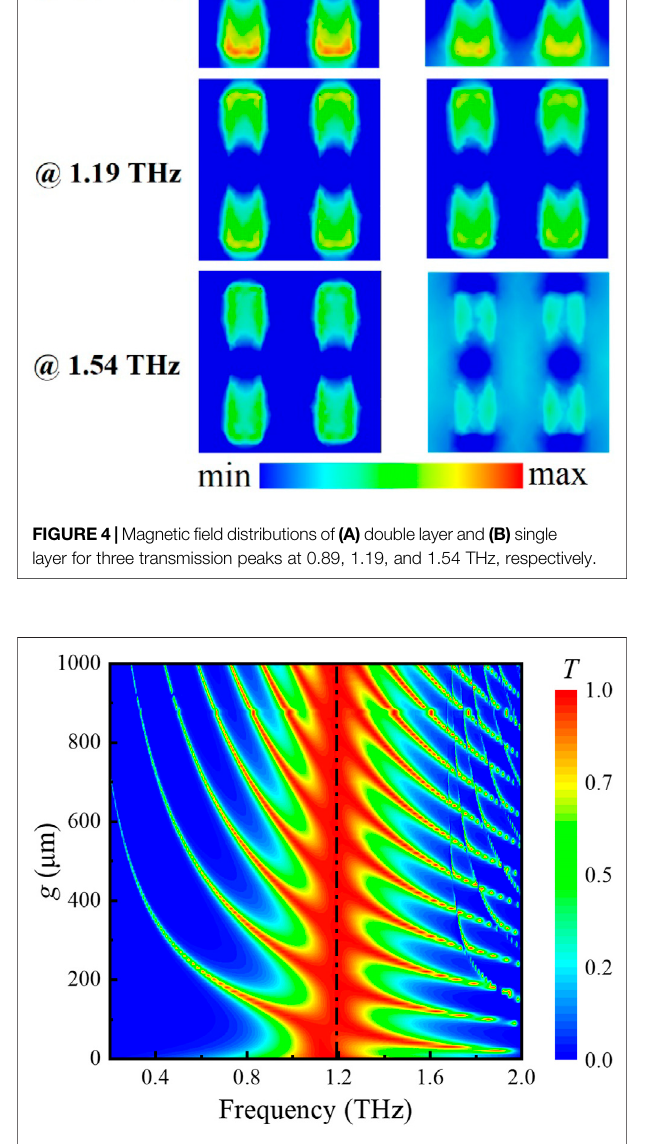
FIGURE 5 | Contour map of the transmittance with changing spacing from 0 to 1,000 μ m at a THz range from 0.2 to 1.8 THz. The vertical highlighted line is at f 2 = 1.19